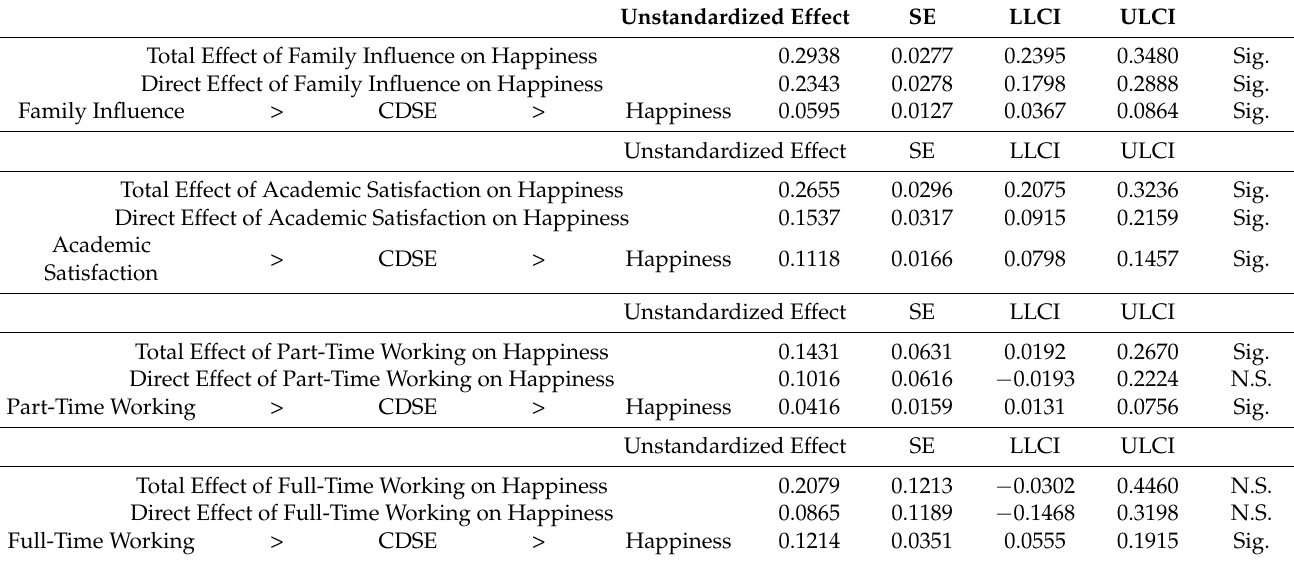
Table 4. Total, direct, and indirect regression analysis on